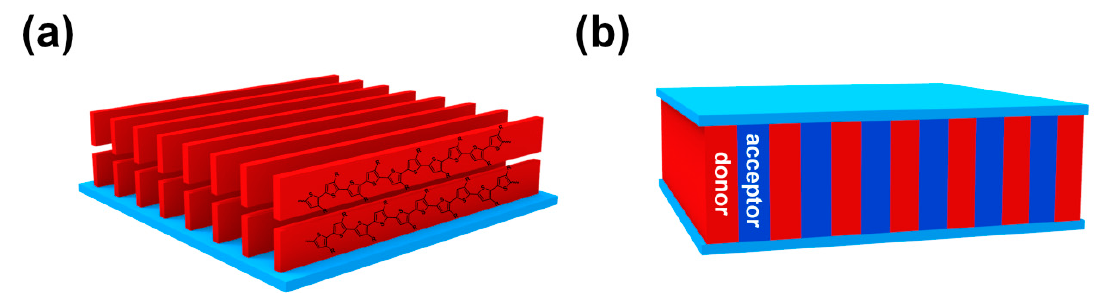
Figure 1. ( a ) The “edge-on” orientation of poly(3-hexylthiophene) (P3HT) that promotes charge transportation; ( b ) the proposed ideal interpenetrated lamellar structure of donor and acceptor materials in organic photovoltaics (OPV) devices.